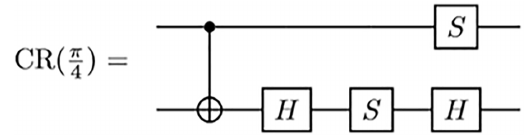
π √ , π √ , π √ , 5 3 2 we can 7 FIG. 9. Infidelities reached by applying (a) stochastic descent search and (b) brute-force (exhaustive) search on the CR gates defined by the angles in Table VI in order to decompose them into discrete circuits. As we can observe, both algorithms pro- vide us with the same results. However, they cannot find a circuit representation with F > 0.98 for the first three gates, thus indi- are longer, more error prone, and harder to